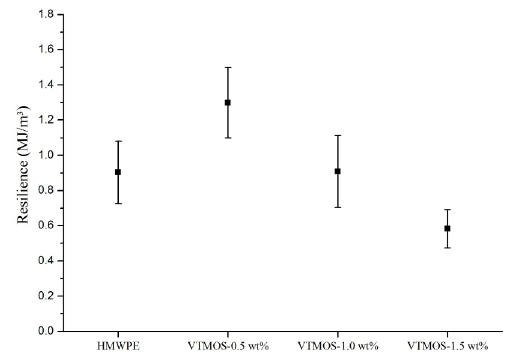
Figure 5. Resilience of HMWPE and VTMOS crosslinked HMWPE